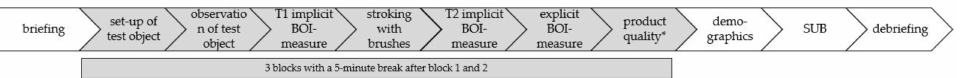
Figure 2. Research flow of the laboratory experiment. SUB = smartphone usage behavior. * Product quality was assessed in smartphone conditions only.